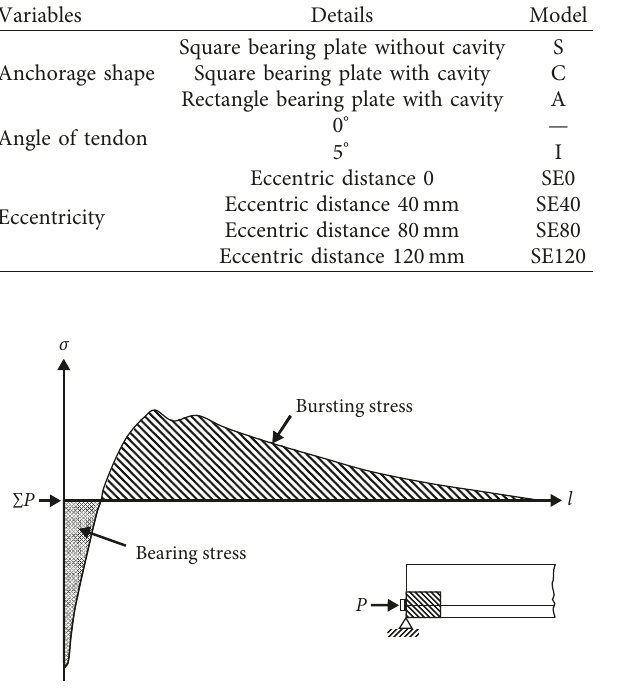
Figure 8: Method used for bursting force calculation.